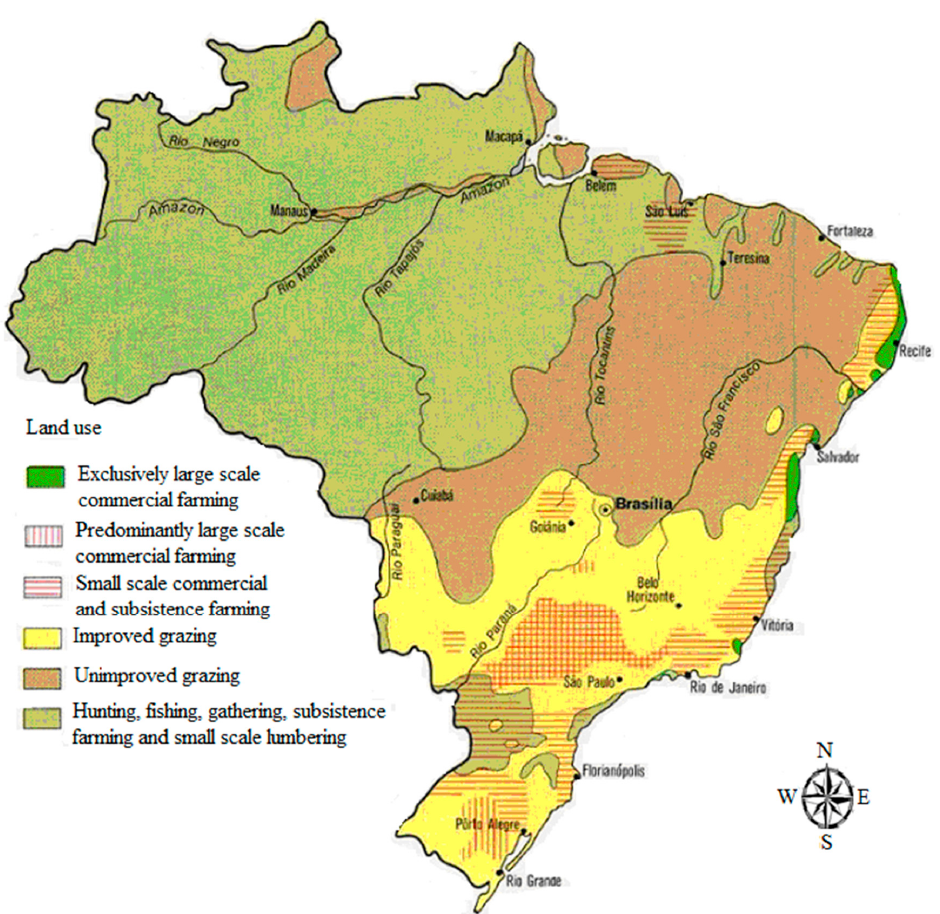
Figure 1. Brazil land use map.